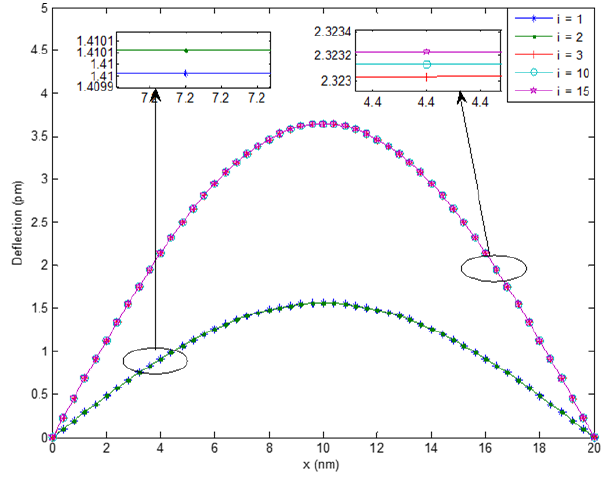
Figure 2. Convergence criteria Table 1. Convergence criteria based on the number of iteration ( i ) in the close form solution for the deflection of the SWCNT